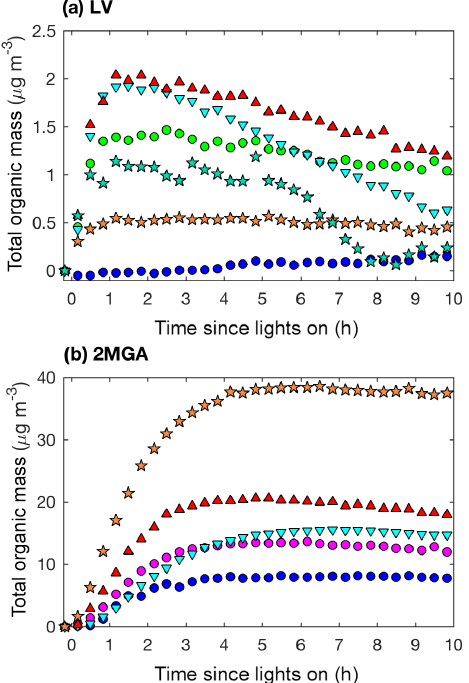
Figure 11. Total organic mass (20min averages) as measured by the AMS for LV pathway experiments (a) : seed surface area (SA) – D1 (SA = 0µm 2 cm − 3 ; blue dot) and D3 (SA = 3420µm 2 cm − 3 ; green dot); temperature – D5 (13 ◦ C; inverted cyan triangle) and D6 (32 ◦ C; red triangle); and new chamber with less wall charging – D10 (SA = 1580µm 2 cm − 3 ; orange star) and D11 (SA = 4770µm 2 cm − 3 ; teal star). Total organic mass as measured by the AMS for 2MGA pathway experiments (b) : seed surface area – M1 (SA = 0µm 2 cm − 3 ; blue dot) and M2 (SA = 1640µm 2 cm − 3 ; magenta dot); temperature – M4 (13 ◦ C; inverted cyan triangle) and M5 (32 ◦ C; red triangle); and new chamber with less wall charging – M9 (SA = 1910µm 2 cm − 3 ; orange